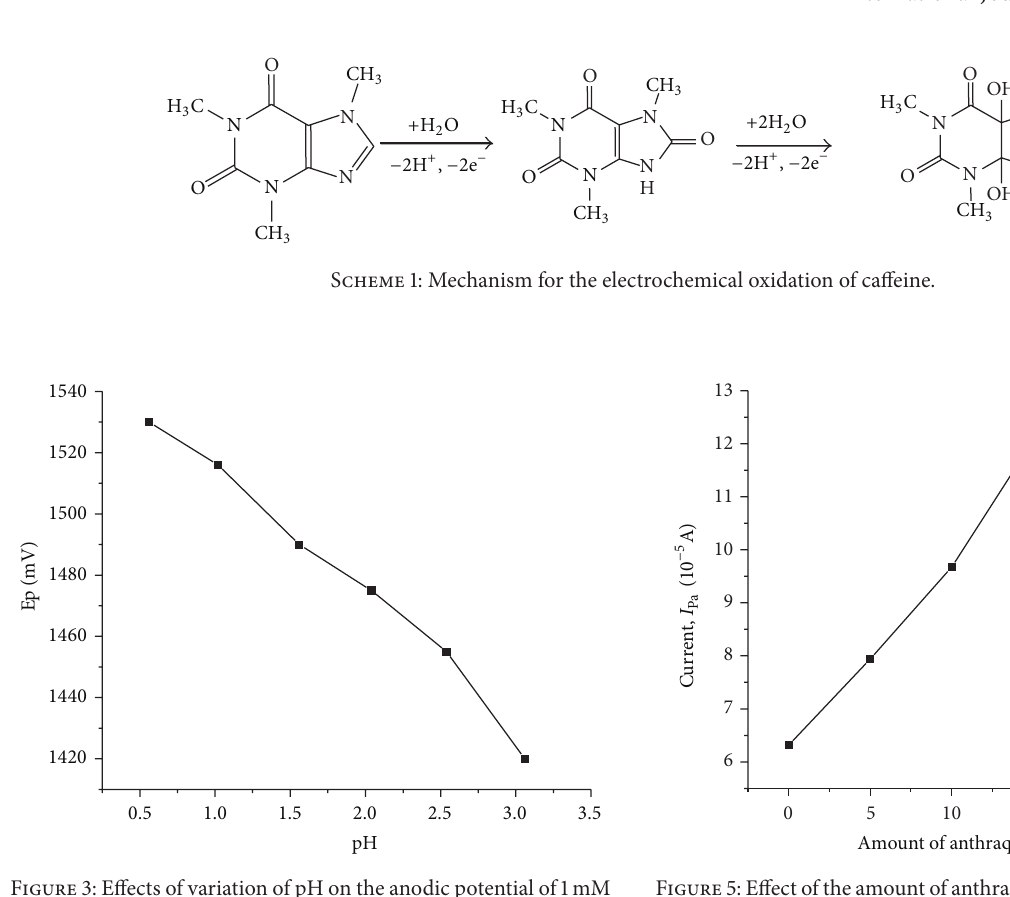
Figure 5: Effect of the amount of anthraquinone on the anodic peak current of 1mM caffeine, in 0.1M HClO 4 (pH 0.56); at scan rate of